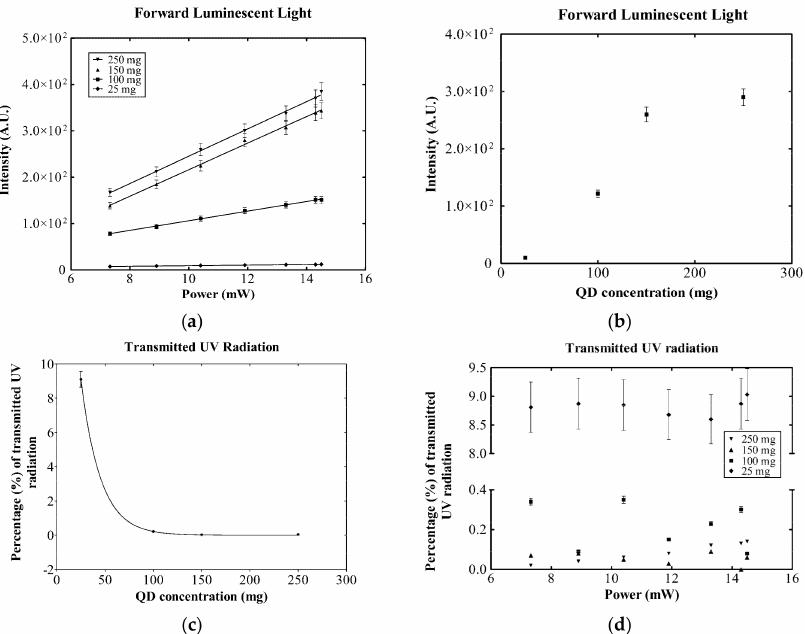
Figure 5. ( a ) The intensity variation of the forward luminescent light while increasing the power of the incident UV radiation; ( b ) the intensity variation of the forward luminescent light while changing the QD concentrations; ( c ) the percentage of the incident UV radiation that passed through the compound films for the four QD concentrations; and ( d ) the percentage of the UV radiation that passed through the compound films by increasing the power of the incident UV radiation.